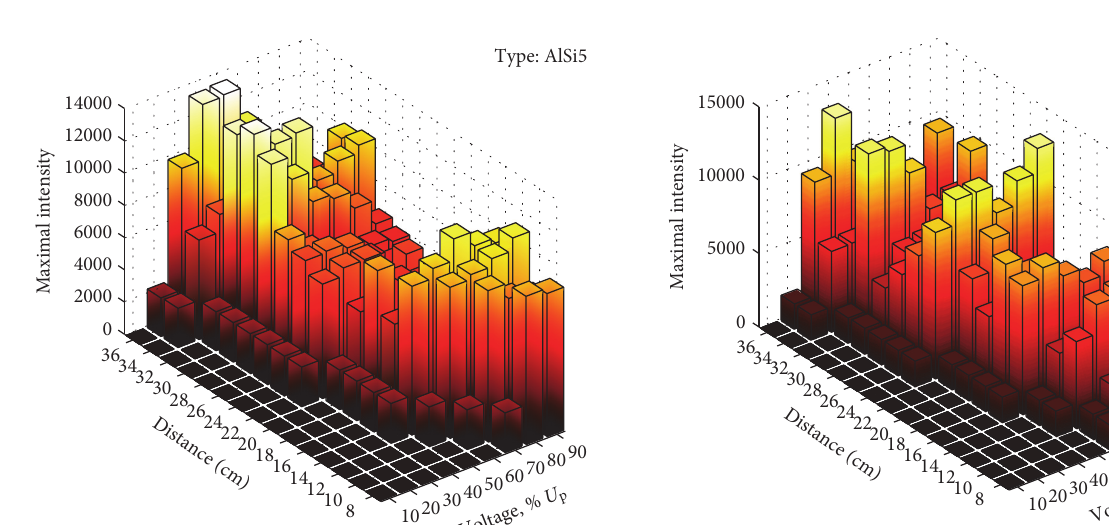
Figure 16: Dependency of voltage and distance on the highest intensity value for the AlSi5